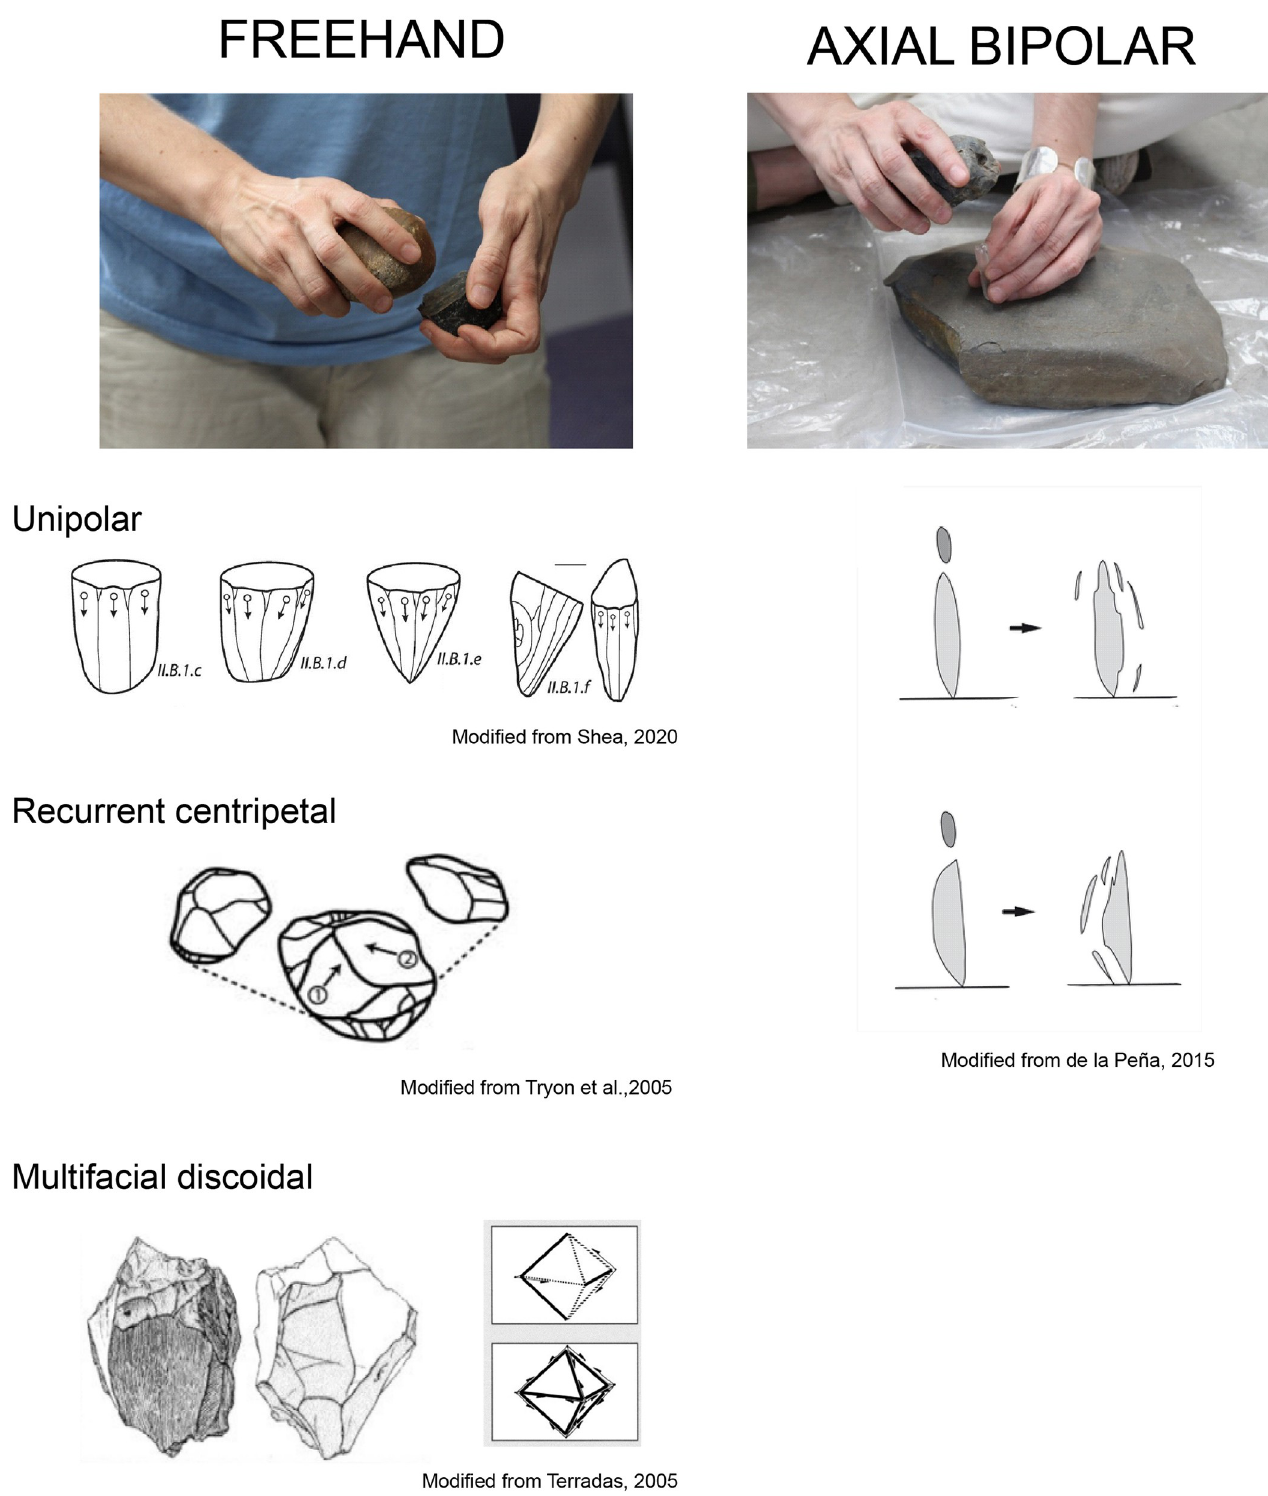
Fig 2. Examples of middle and later stone age reduction sequences employed in this knapping experiment: Discoidal, Levallois recurrent, unidirectional, and axial bipolar. The figures are modified from [15, 26–28]. On the left freehand variants and on the right bipolar axial variant towards miniaturization. Photos: Paloma de la Pe ñ